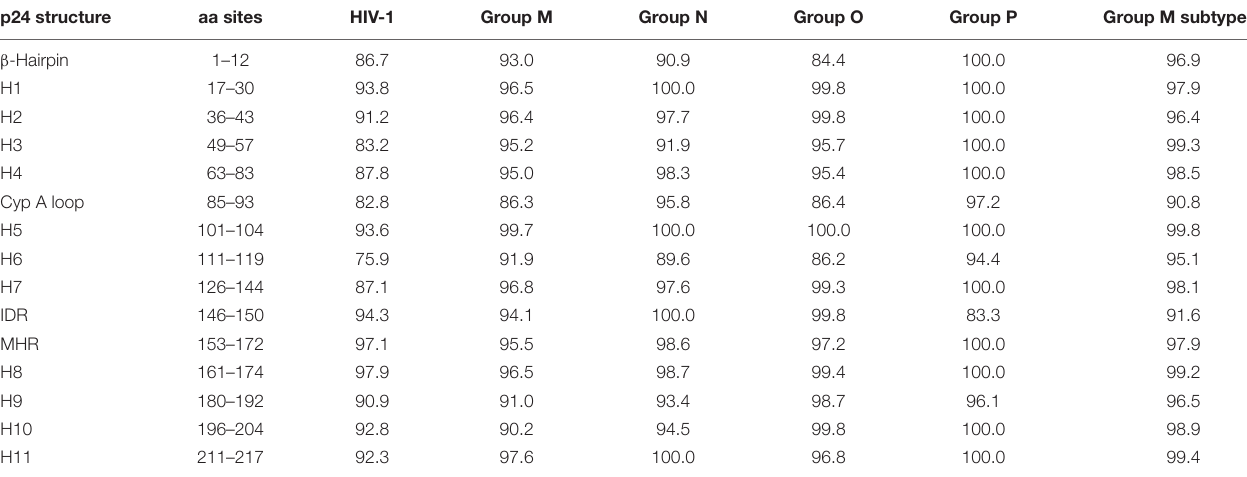
FIGURE 2 | HIV-1 consensus mean conservation of each element in p24 secondary structure. H, helix; IDR, interdomain linker region; MHR, major homology region; in light blue, N-terminal domain; in light yellow, C-terminal domain. The boxes indicate the residues included in each structure except for the MHR, indicated in dark orange. TABLE 2 | Conservation of each element of p24 secondary structure in HIV-1, the four HIV-1 groups, and group M subtype B consensus. p24 structure aa sites HIV-1 Group M Group N Group P Group M subtype